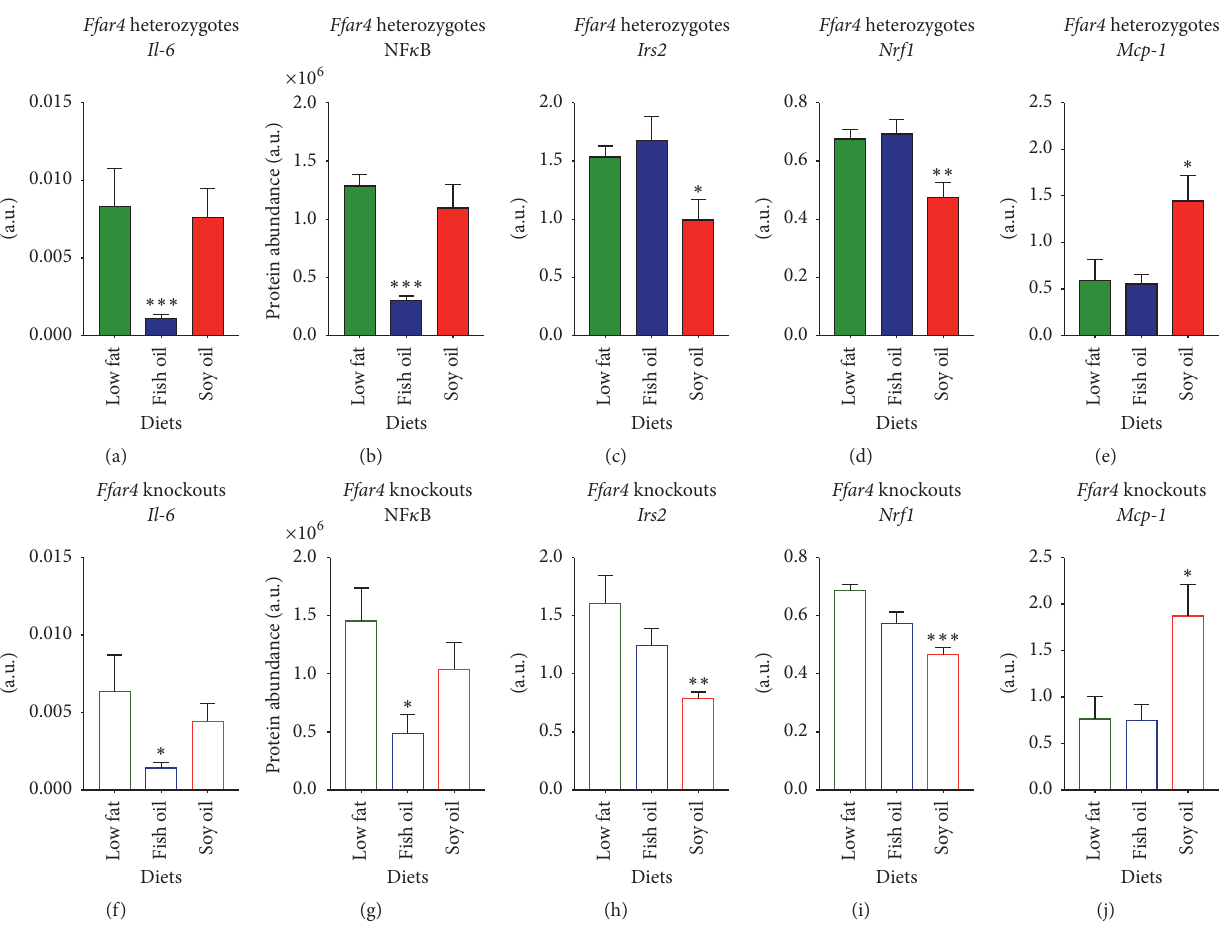
Figure 4: Intake of a high fat 𝜔 3-PUFA diet alleviates hepatic steatosis in Ffar4 HET and KO mice. Mice were euthanized in nonfasting state 36 weeks after diet initiation. Gene expression levels were analyzed by RT-qPCR and protein levels were evaluated by western blot analysis. ((a)–(e)) Heterozygotes. ((f)–(j)) Knockouts. ((a) and (f)) mRNA level of Il - 6 , 𝑛 = 5 –7. ((b) and (g)) Protein level of NF 𝜅 B, 𝑛 = 6 –8. ((c) and (h)) mRNA level of Irs2 , 𝑛 = 6 –8. ((d) and (i)) mRNA level of Nrf1 , 𝑛 = 6 –8. ((e) and (j)) mRNA level of Mcp - 1 , 𝑛 = 6 –8. Data are presented as means ± SEM. Both HFDs have been compared to the LFD. All data have been Ln-transformed and 1-way ANOVA with Bonferroni correction was performed. Only statistical significant differences are shown. ∗ 𝑝 < 0.05 , ∗∗ 𝑝 < 0.01 , and ∗∗∗ 𝑝 < 0.001